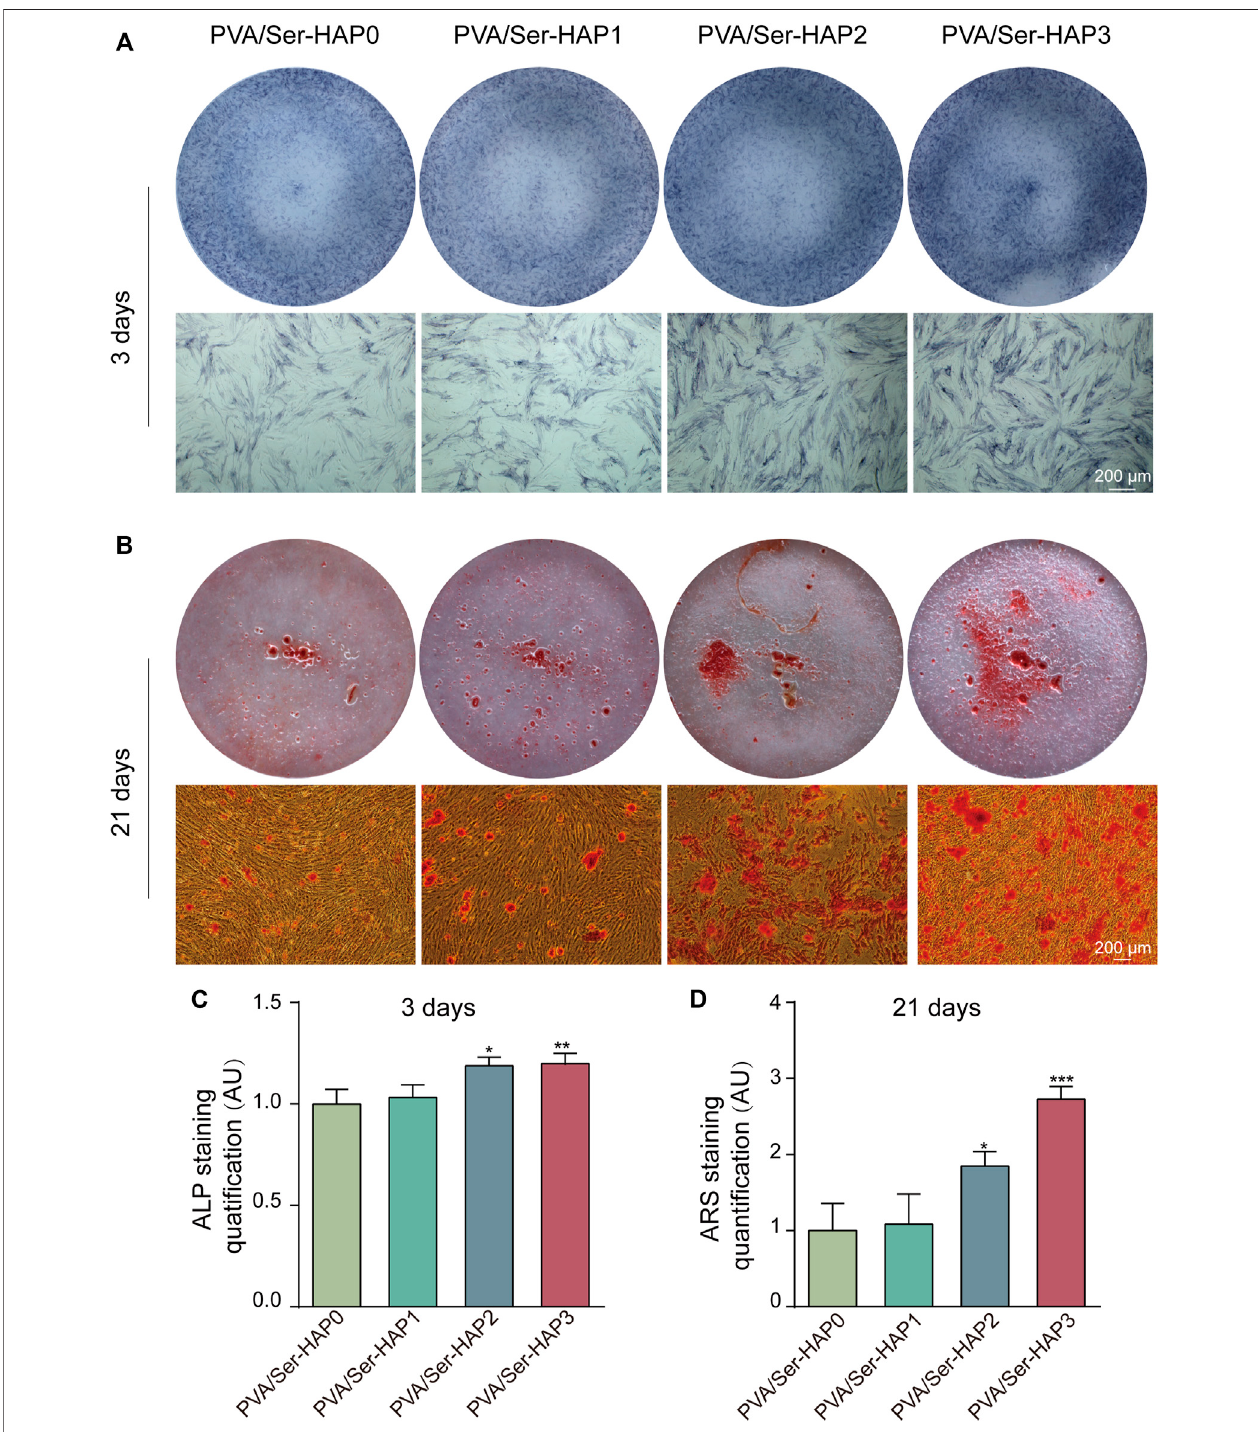
FIGURE 8 | (A) ALP staining of the hPDLSCs following cultured by extracts of PVA/Ser-HAP membranes for 3 days; (B) Alizarin red staining of the hPDLSCs after cultured by extracts of the membranes for 21 days; (C) Quantitative analysis of ALP staining at 3 days; (D) Quantitative analysis of Alizarin red staining at 21 days.